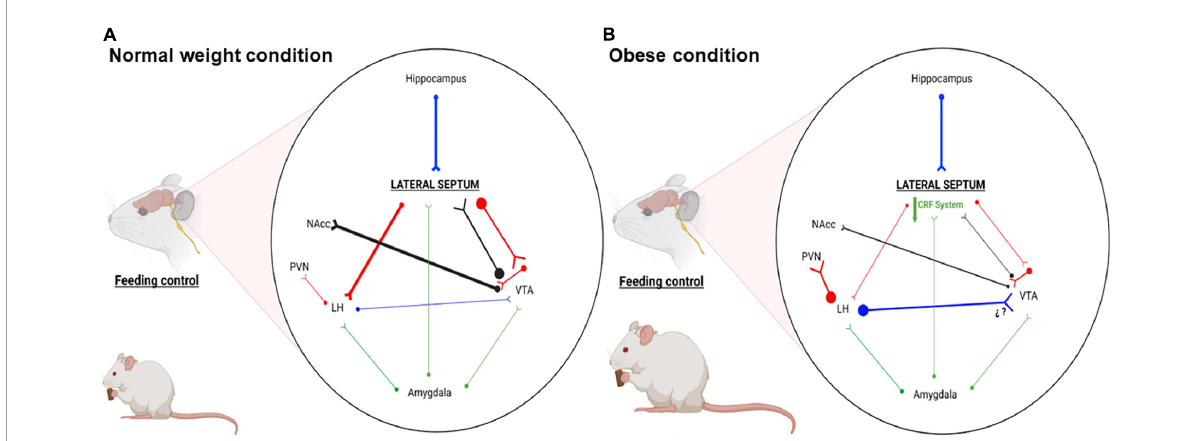
FIGURE1 Schematic representation of the main LS connections associated with motivation, stress, emotional and feeding behaviors. (A) Representative connectivity in normal weight condition: LS GABAergic efferents regulate activity of LH and VTA neurons, impacting behaviors such as hunger and motivation. (B) Representative connectivity in obese condition: Our proposal shows that LS CRF system is downregulated, reducing the activity of LS GABAergic efferents. This reduced activity favors hyperactivation and hypoactivation of LH and VTA, leading to hyperphagia and less reward for foods. Blue, glutamatergic neurons; Red, GABAergic neurons; Black, dopaminergic neurons; Green, CRFergic neurons; NAcc, nucleus accumbens; LH, lateral hypothalamus; PVN, paraventricular nucleus; VTA, ventral tegmental area. This figure was created with BioRender.com under subscription and have a license of Biorender to use the figure in journal